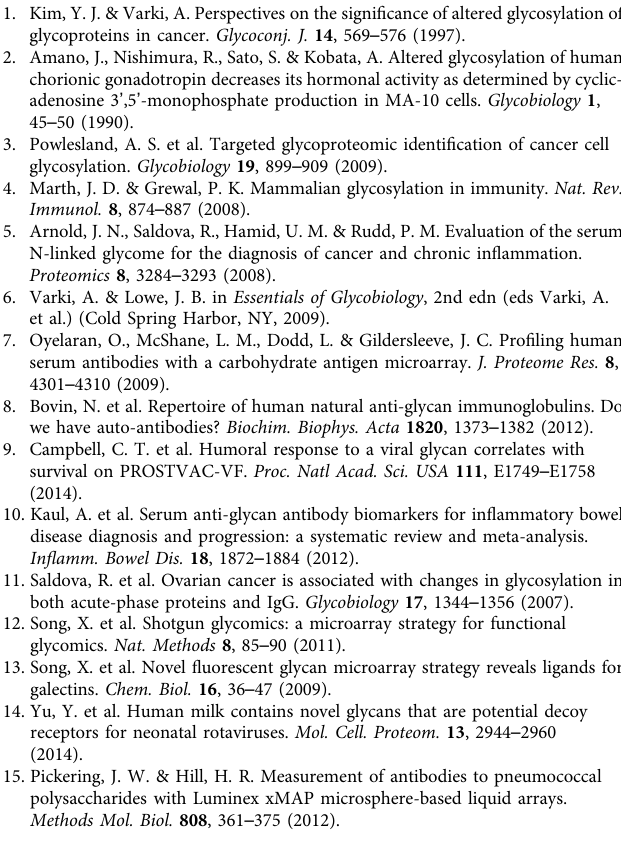
Data analysis . Raw data fi les from Luminex FM3D machine were processed using a software pipeline, which we have developed for quality control, visualization and normalization of raw Luminex data. Wells with individual bead counts below 30 were fl agged for exclusion and were not included in further analyses. The average of three no glycan control (NGC) beads was compared with the mean MFI value for each glycan without sample (blank control). The higher value of NGC and blank control was used for background subtraction. Bar plots represent mean MFI with standard deviation values as error bars from replicates. Dot-plots were gen- erated to summarize the distribution of MFI levels for each glycan on log2 scale, each sample for each glycan is represented using a dot. The binding levels of the natural antibodies in human serum were described using four categories: no binding: MFI < 3×SD of the no glycan control (NGC), weak/low binding: mean MFI of NGC+3×SD, elevated/moderate: MFI > 5× mean MFI of NGC and strong/high: MFI > 20× mean MFI of NGC. Visualization of MFI matrix was performed using heatmap, after log2 transformation, to graphically summarize the global interaction between glycans and glycan-binding proteins. The red color was used to represent larger values and green color was used to represent smaller values. Hierarchical clustering was performed to discover the patterns and to arrange the pro fi les based on the glycan-GBP interactions. To assess the prognostic potential, we used Cox regression analysis and Log-Rank test to evaluate the impact death of patient. Patients who are alive with no evidence of disease were censored at the date of last follow-up visit. Kaplan – Meier plots are shown and statistical